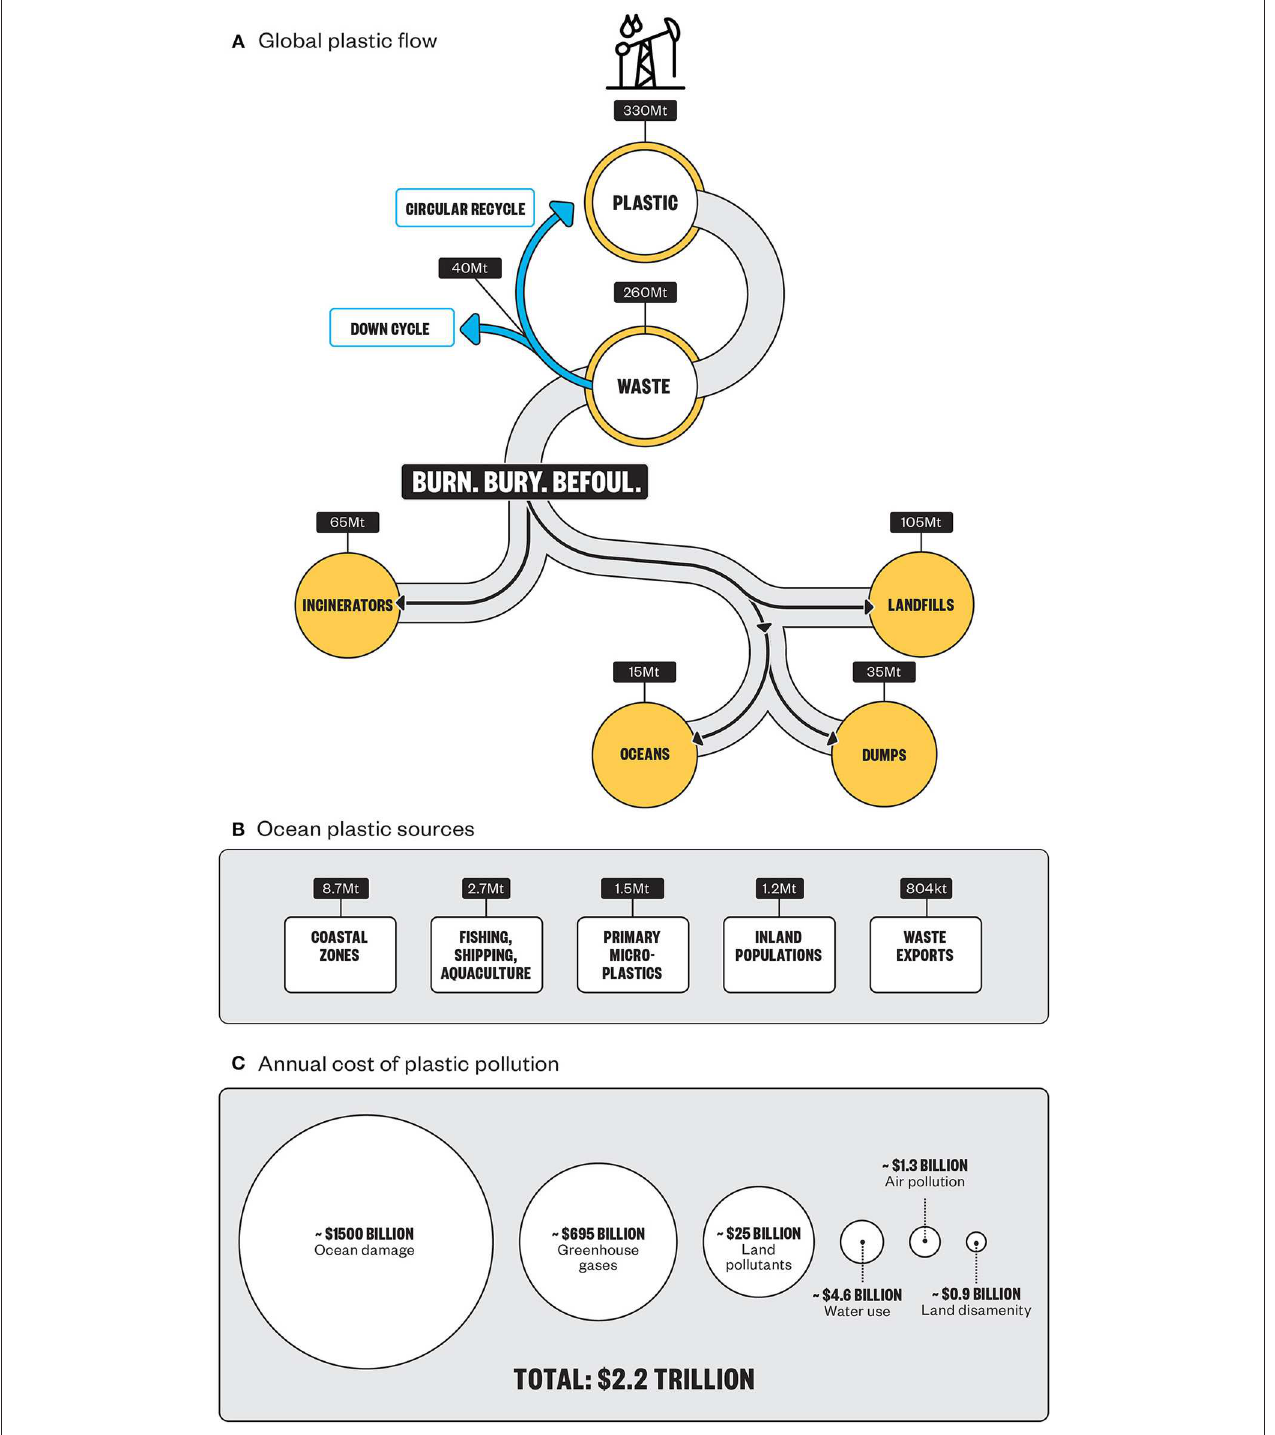
FIGURE 1 | The plastic problem. (A) Global plastic flow in 2016, as estimated by Hundertmark et al. (2018). Numbers within black boxes represent amounts (million tonnes per year) of plastics produced, wasted, recycled, incinerated, landfilled, dumped and leaked to oceans. (B) Break-down of the different sources of ocean plastics, in million tonnes per year: coastal zones (Jambeck et al., 2015), fishing (Watson et al., 2013; Bell et al., 2017; Lebreton et al., 2018), shipping (Halpern et al., 2008; Lebreton et al., 2018), aquaculture (FAO, 2016a; Lebreton et al., 2018), primary microplastics (Boucher and Friot, 2017), inland populations (Lebreton et al., 2017, 2018), and waste exports (UN Trade Statistics, 2018). (C) Break-down of the different costs associated with plastic pollution in US$ per year: ocean damage (Beaumont et al., 2019), greenhouse gases (Ricke et al., 2018; Zheng and Suh, 2019), land pollutants, water usage, air pollution, and land disamenity (UNEP, 2014). The data, limitations and assumptions used for the plastic mass flow and environmental economic analysis are described in Supplementary Materials .